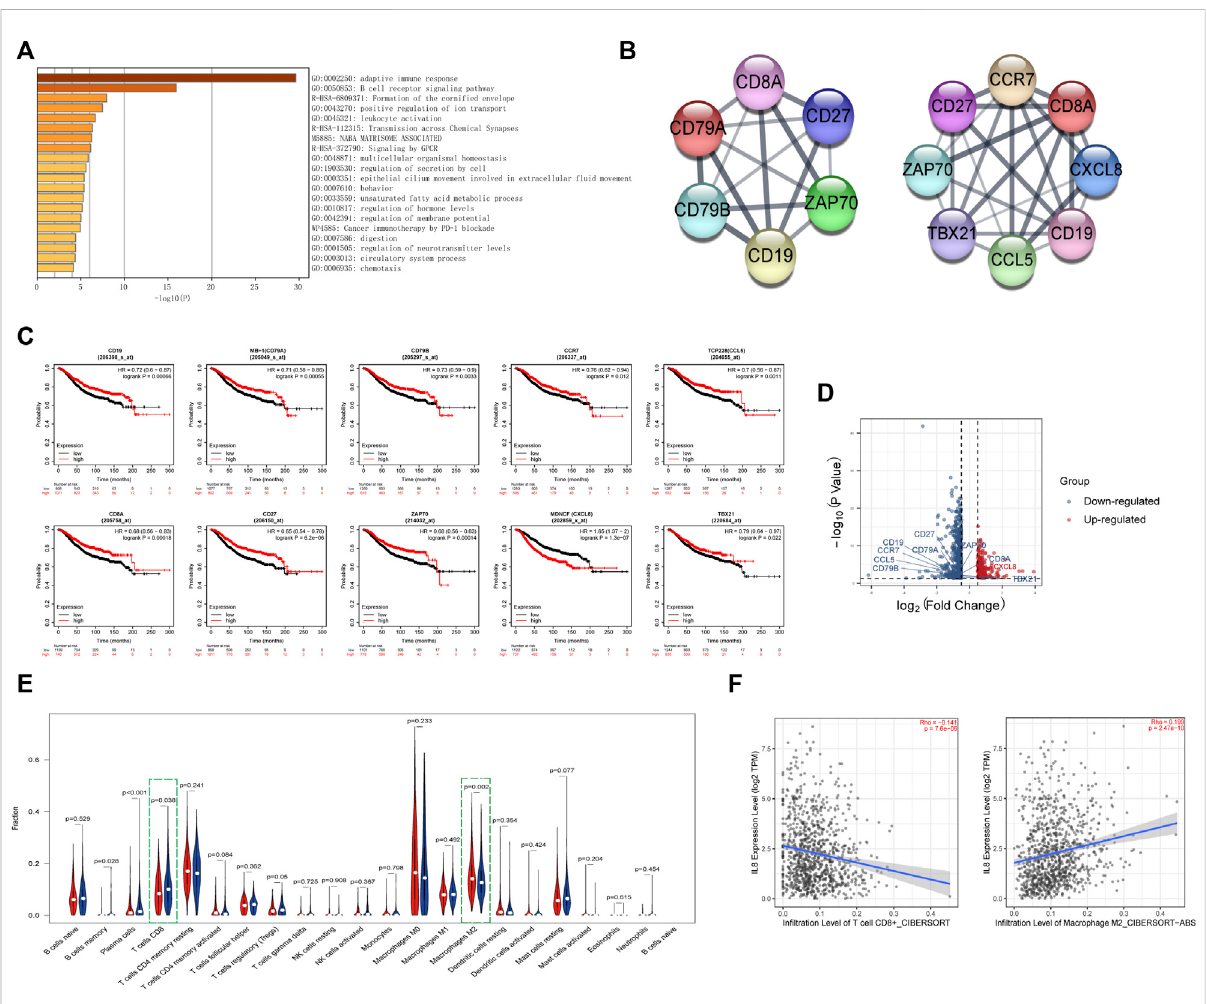
FIGURE 6 Identi fi cation of the immune-related pathways involved in the differentially expressed genes between high- and low-risk groups. (A) . The enrichment pathways for the differentially expressed genes between the high- and low-risk groups. (B) . The hub genes related to the adaptive immune pathway and the B-cell receptor signaling pathway. (C) . Kaplan – Meier curves of overall survival of the hub genes for breast cancer patients in Kaplan-Meier Plotter database. (D) . Volcano plot of hub genes between the high- and low-risk groups. The right red labeled gene was signi fi cantly higherinthehigh-riskgroup thanthelow-riskgroup, andtheleftbluelabeledgenesweresigni fi cantly lowerinthehigh-riskgroup than thelow-riskgroup. (E) .Boxplotofthein fi ltrationlevelofimmune-associatedcellsinthehigh-andlow-riskgroups. (F) .TheexpressionofCXCL8was negatively correlated with CD8 + T cell in fi ltration and positively correlated with M2 macrophage in fi ltration in TIMER 2.0